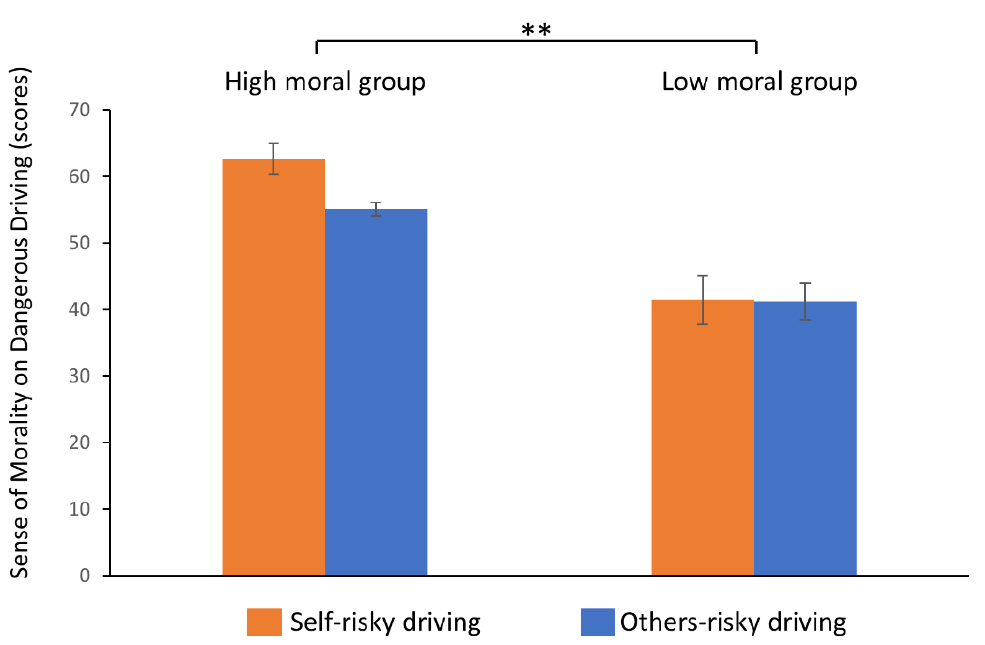
Figure 2. Results of moral values for driving behavior. Bars depict mean ± standard error. Statistics: Repeated measure two-factor ANOVA was performed; ** p < 0.01.